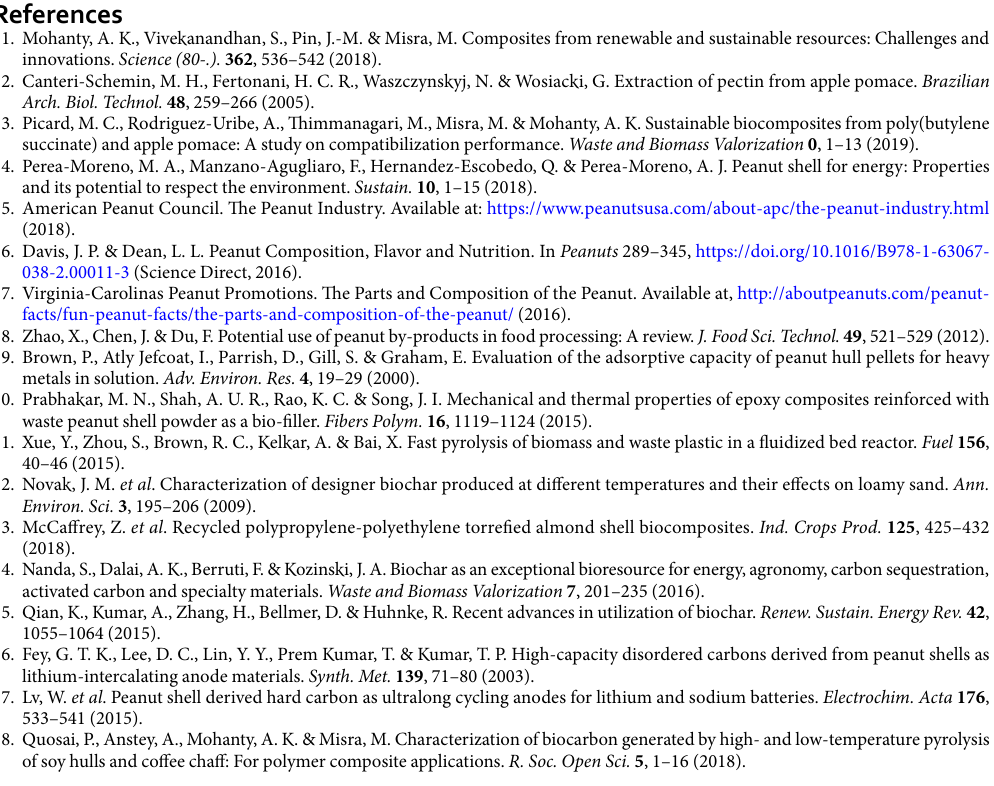
temperature biocomposite applications, the PHs were subject to thermochemical conversion (pyrolysis). Samples were heated to 500 °C in an inert atmosphere. After the pyrolysis, the resulting biocarbon was examined for its chemical structure, conductivity and morphology. Raman spectroscopy determined that the samples contained higher graphitic content than disordered carbon content. The electrical conductivity was relatively low, suggesting uses in anti-static applications. The surface morphology of the samples was maintained after the pyrolysis process. The PH biocarbon was combined at 20wt.% with 80wt.% poly(trimethylene terephthalate) (PTT). The resulting composites improved the renewability content to 48% and experienced increases in both the flexural and tensile moduli by at least 130%. The successful fabrication of PH biocarbon composites is just one of the potential, sus- tainable and value-added uses which peanut hulls offer.